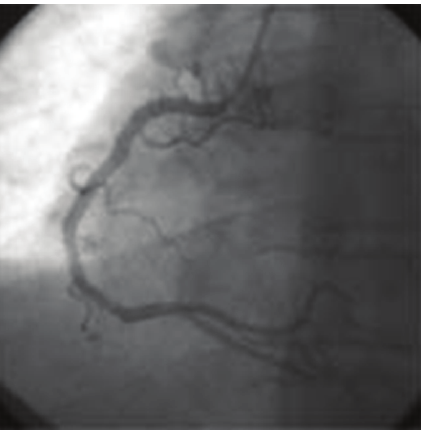
Figure 3: Right coronary artery angiogram after successful stent implantation.